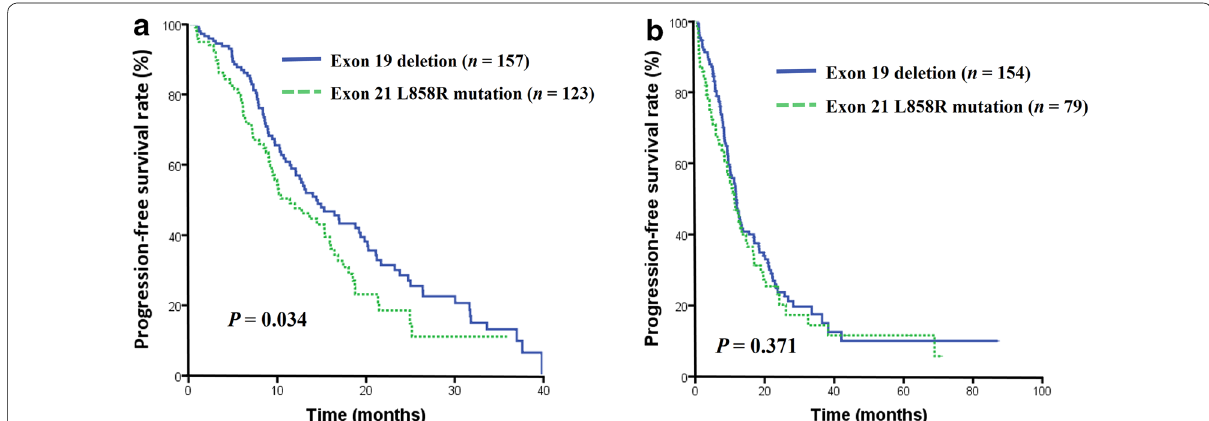
Fig. 1 Progression‑free survival ( PFS ) curves of epidermal growth factor receptor ( EGFR )‑mutated patients treated with tyrosine kinase inhibitors ( TKIs ). a PFS curves of patients with the EGFR exon 19 deletion (19 del) and exon 21 L858R point mutation (L858R mutation) who received first‑line TKI therapy (14.4 vs. 11.4 months, P 0.034); b PFS curves of patients with the EGFR 19 del and L858R mutation who received second‑line or greater = TKI therapy (11.7 vs. 11.2 months, P 0.371) =